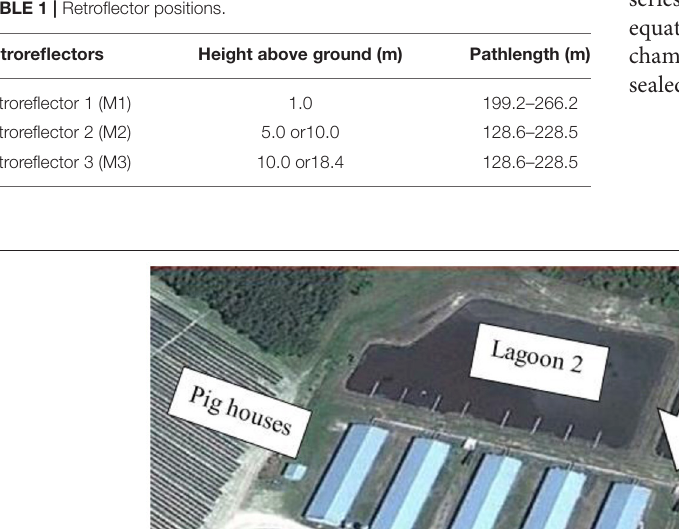
Frontiers in Sustainable Food Systems |